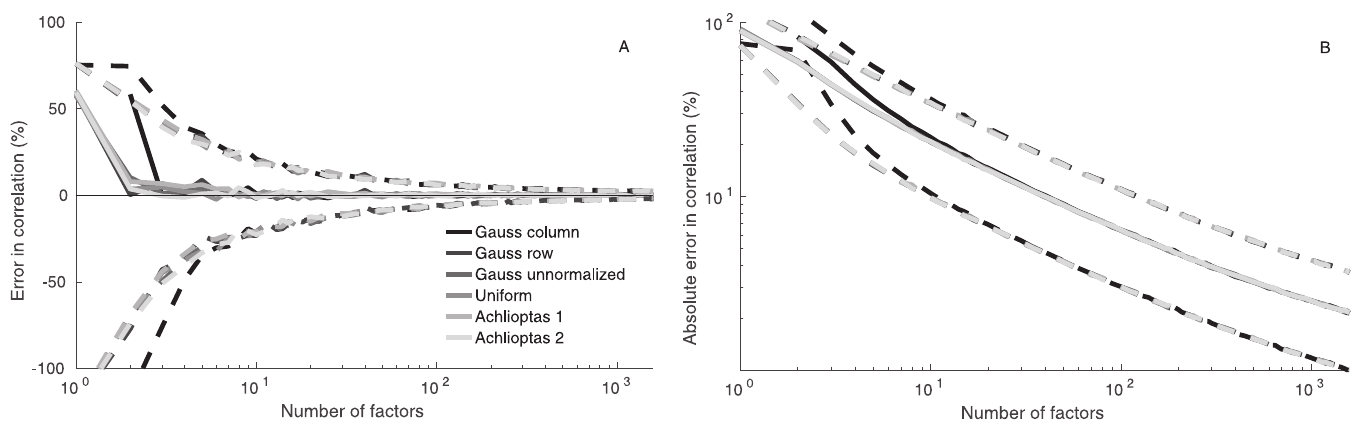
Fig 8. Comparison of six different projection matrix specifications. Solid lines are median estimates, dashed lines the 25th and 75th percentiles. Error in correlation coefficient estimates as functions of the number of factors in six models (left panel). Error is computed from the entire set of correlation pairs in 1,591 time-series. Absolute error in correlation coefficient estimates in the six models as functions of the number of factors (right panel).